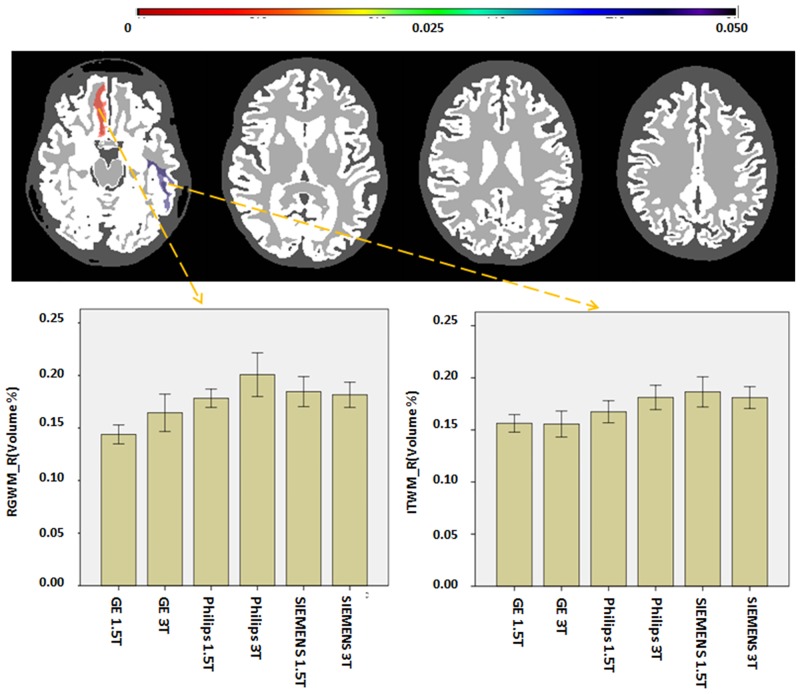
Regional volumes affected by the differences in protocol.The volumes are normalized by the “total brain” volume (parenchyma plus CSF). Two regions (left inferior temporal gyrus [ITWM_L] and the right rectus gyrus [RGWM_R] white matter) showed significantly smaller volumes on the GE scanners.